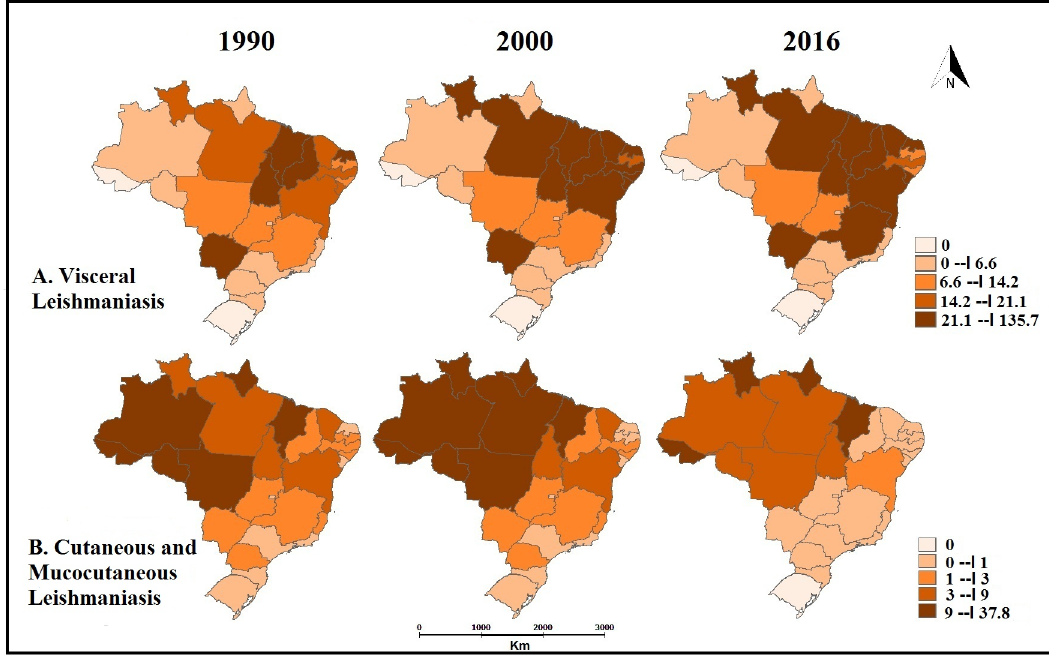
Fig 4. Age-standardized rates of years of life lost (YLL) for Visceral Leishmaniasis (A) and years lived with disability (YLD) for Cutaneous and Mucocutaneous Leishmaniasis (B) per 100,000 inhabitants in 1990, 2000 and 2016 considering the federated units of Brazil. GBD Study